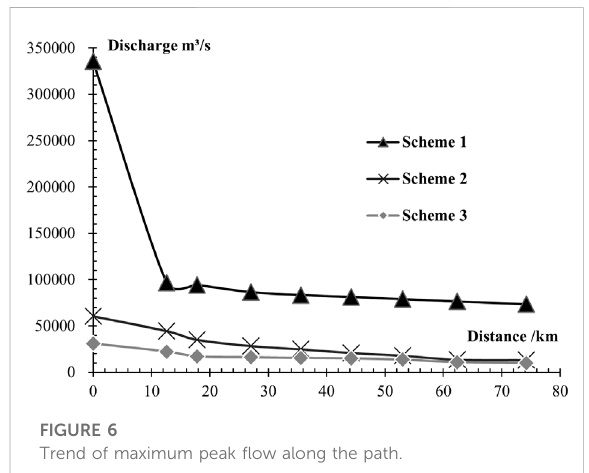
FIGURE 6 Trend of maximum peak fl ow along the